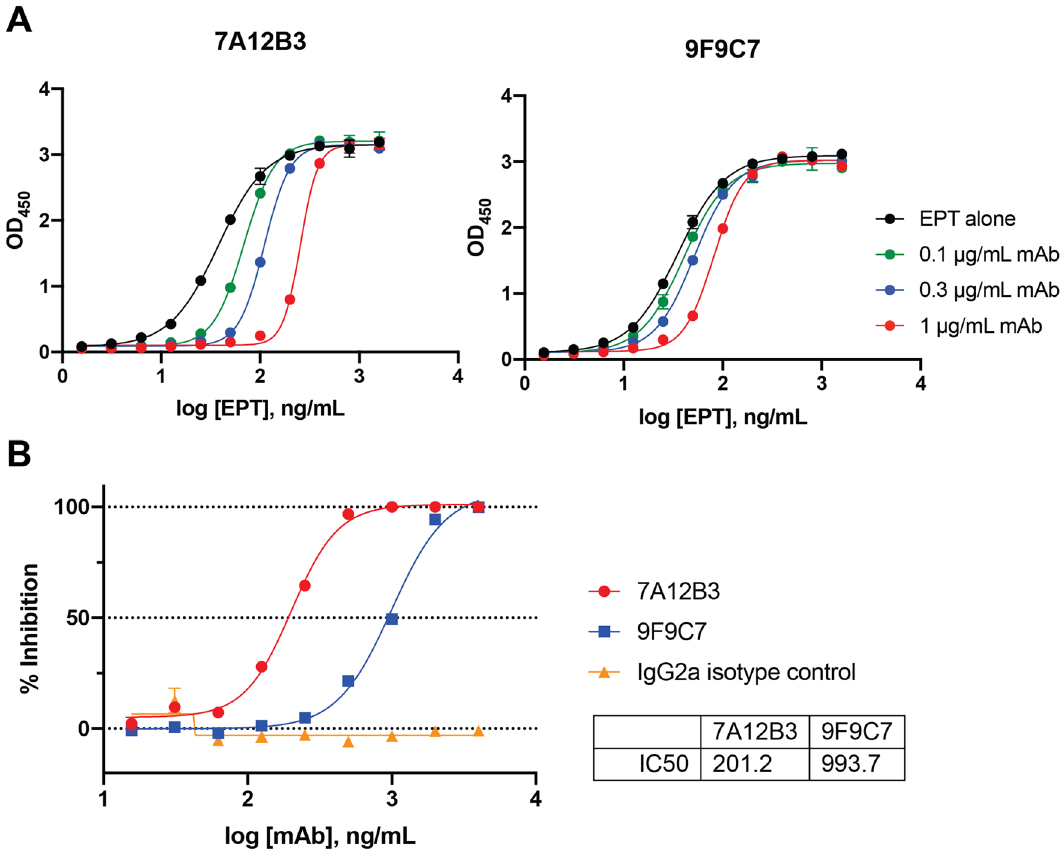
Figure 4. The 7A12B3 mAb, but not 9F9C7, blocks EPICERTIN binding to GM1 ganglioside. EPICERTIN and GM1-capture KDEL-detection (GM1/KDEL) ELISA methods were employed to reveal the impact of 7A12B3 and 9F9C7 mAbs on CTB’s binding to the ganglioside receptor. ( A ) Three concentrations of each antibody (0.1, 0.3 and 1.0 μg/mL) were preincubated with varying concentrations of EPICERTIN and applied to ELISA plates coated with GM1. Plate bound EPICERTIN was detected with an anti-KDEL mAb, as described previously 22 . The 7A12B3 mAb concentration-dependently blocked the interaction of EPICERTIN with GM1 at 0.1–1 µg/ mL, whereas the 9F9C7 mAb had much less effects. ( B ) A competitive GM1/KDEL ELISA was employed to determine the effect of mAbs on EPICERTIN–GM1 interaction. Varying concentrations of respective mAbs, including a rat IgG2a isotype control, were pre-incubated with 100 ng/mL of EPICERTIN and applied to ELISA plates coated with GM1. Plate-bound EPICERTIN was detected with an anti-KDEL mAb, as described previously 22 . Half maximal inhibitory concentration (IC50) of 7A12B3 (201.2 ng/mL) and 9F9C7 (993.7 ng/mL) mAbs were determined by a non-linear regression analysis using GraphPad Prism 9. Data were obtained from at least three independent experiments, and representative graph from one experiment is shown. Each data point represents the mean ± range of duplicate